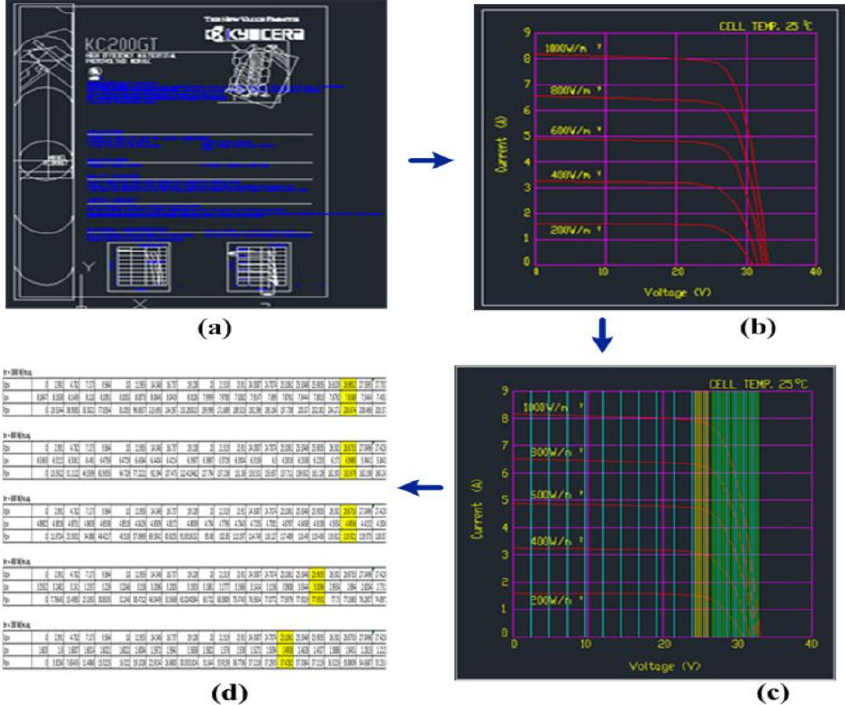
Figure 3. Step by step transformation of I-V curves from raw datasheet to useful data, ( a ) the form of data sheet after conversion into CAD; ( b ) the appearance of curves after removal of unnecessary information; ( c ) the scaling of curves as per actual dimensions and measurements; ( d ) final furnished form of the processed